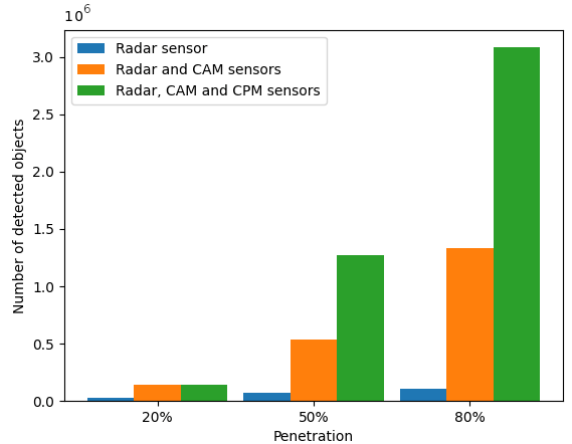
Figure 13. The total number of detected objects in the different